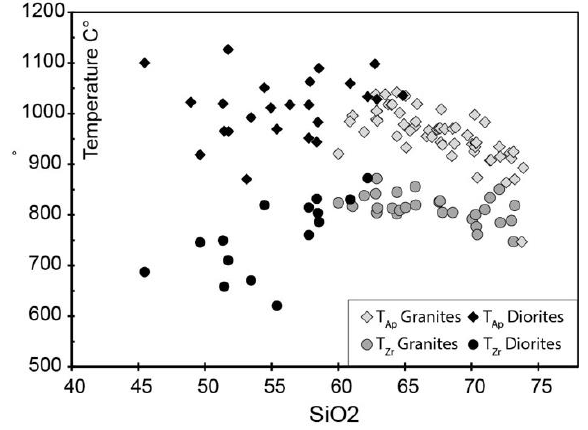
Figure 11. Zirconium and apatite saturation temperatures plotted against SiO 2 . There is a very clear temperature difference between the two saturation temperatures which suggests that zirconium was never saturated at high magma temperatures.